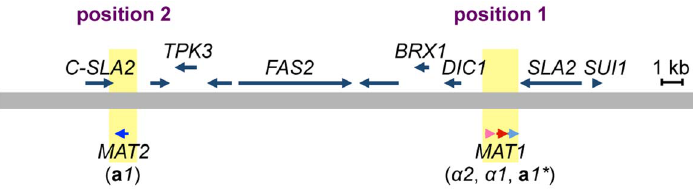
Figure 2. Two mating type loci in H.polymorpha . Schematic of the chromosomal region surrounding MAT1 and MAT2 . The chromosome is represented by a thick grey line; a 2 , a 1 , a 1* and a 1 genes are indicated by pink, red, and light and dark blue arrows, respectively. MAT loci are indicated by yellow. Predicted ORFs are indicated by blue arrows above the chromosome. Chromosomal positions proximal and distal to SLA2 are marked as positions 1 and 2,